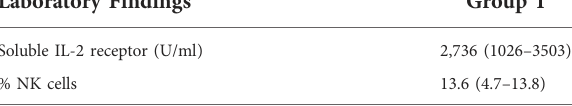
TABLE 3 Results of additional laboratory tests of group 1 on the fi rst day of